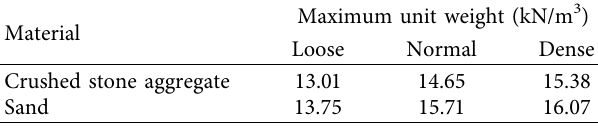
Table 2: Maximum material unit weight for crushed stone ag- gregate and sand based on compaction condition.